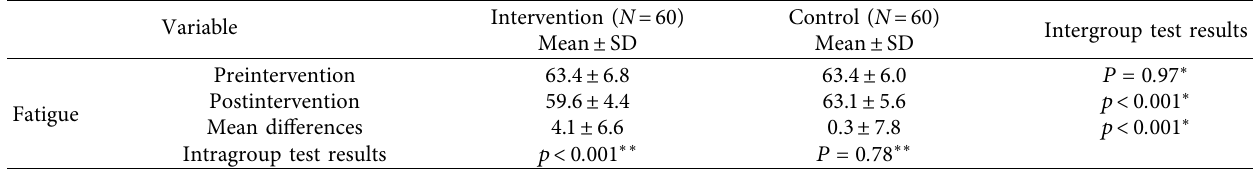
Table 3: The mean score of fatigue before and after intervention in CCNs.